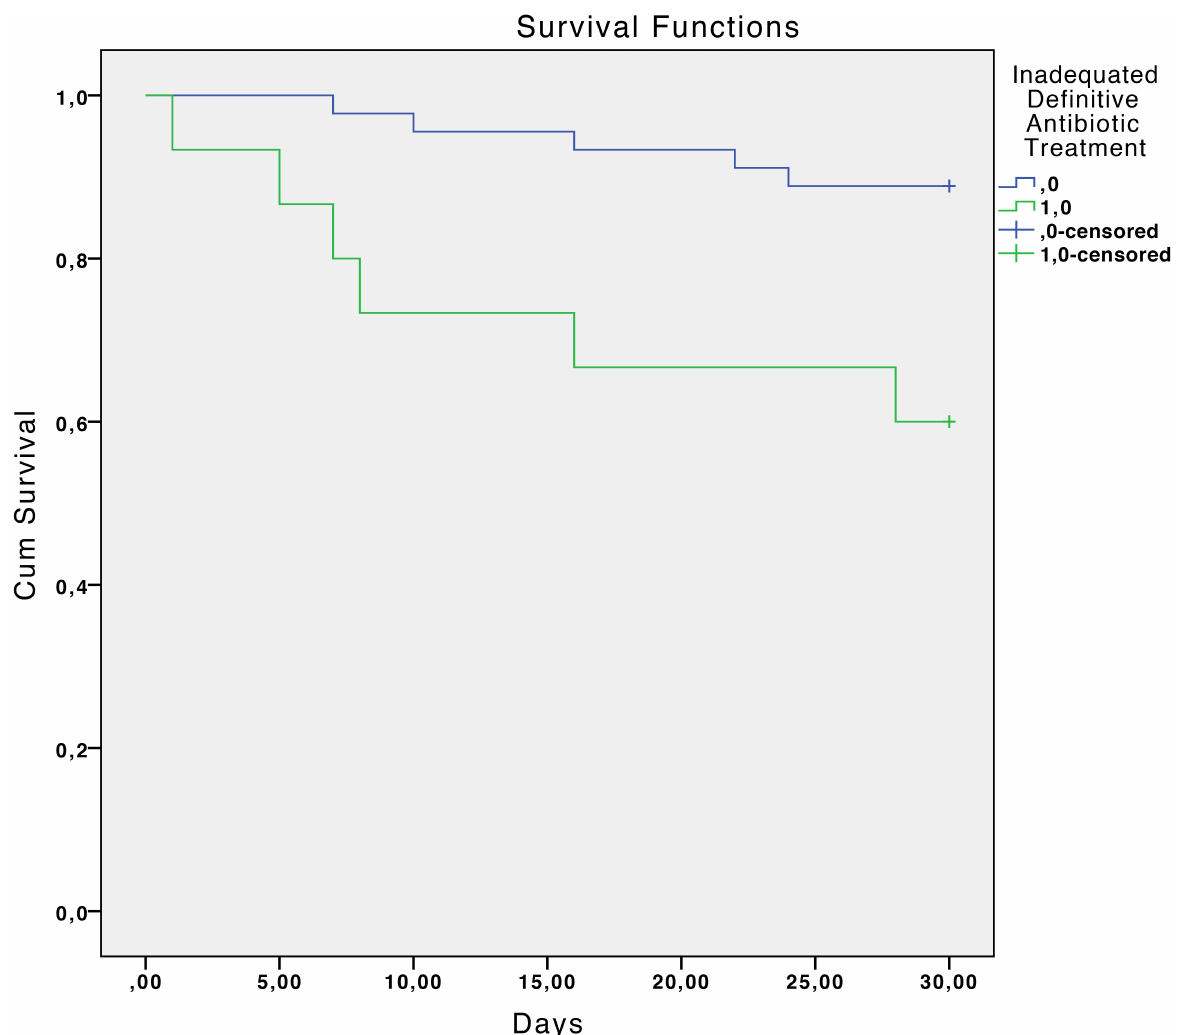
Fig 6. Kaplan-Meier 30-day survival curve according to inadequate antibiotic treatment. P < 0.01(log-ranktest).